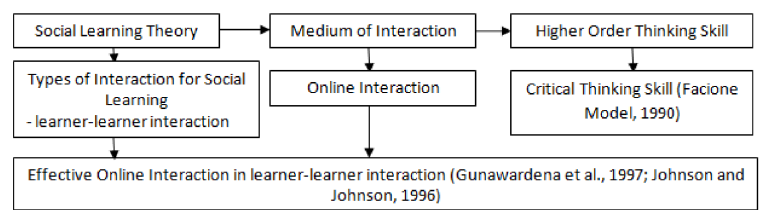
Figure 3. The basic framework of online interaction in social learning to promote critical thinking